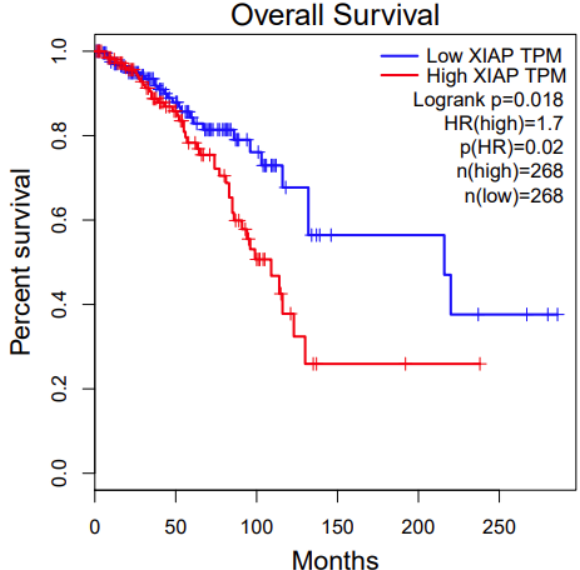
Figure 4. Survival analysis of XIAP in TCGA BRCA.